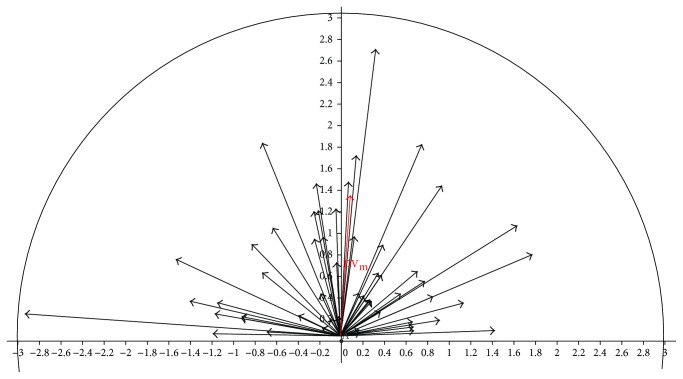
Visualization of all difference vectors from the vector analysis (n = 64); DVm = mean difference vector.